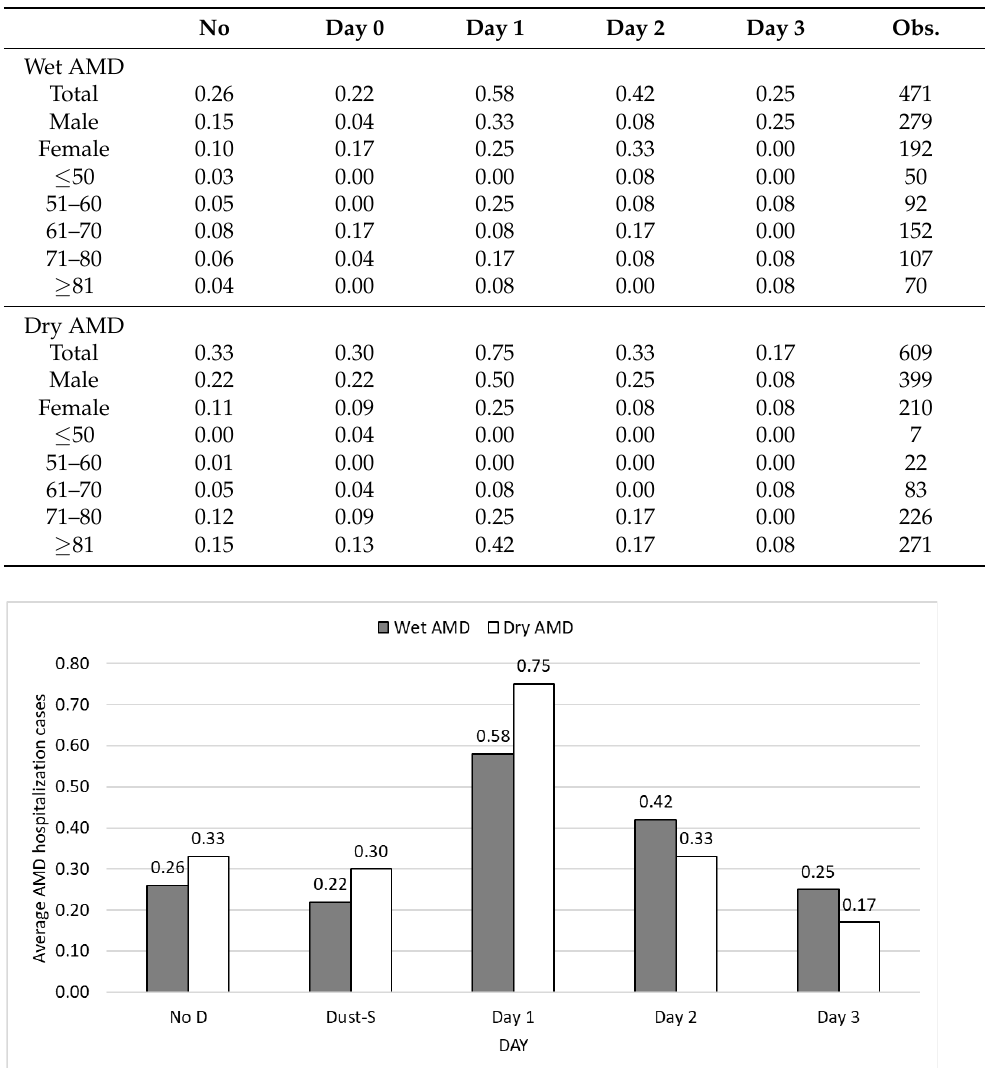
Table 2. Average daily AMD inpatient care according to days after DSs stratified by gender and age.